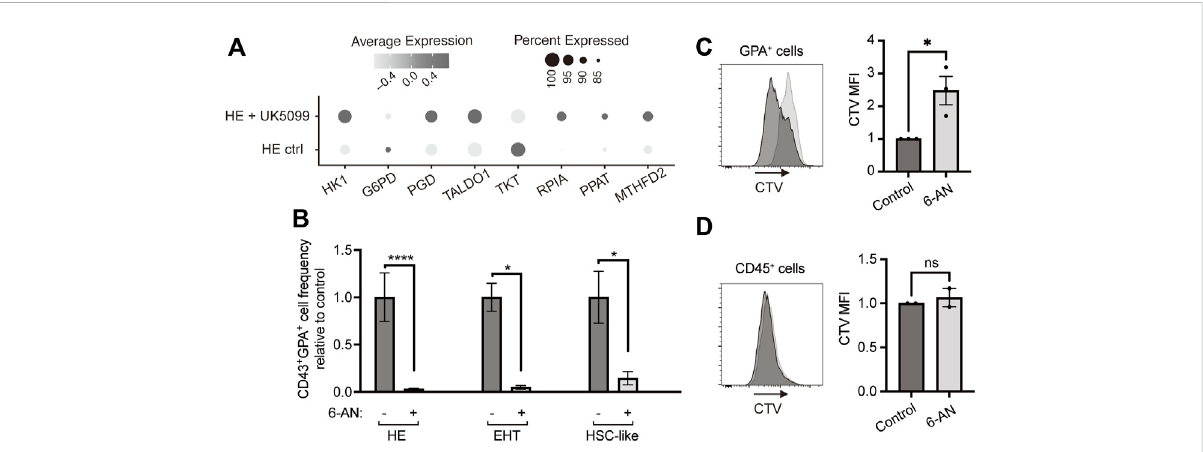
FIGURE 1 BlockingthepentosephosphatepathwayinhibitsHE-derivederythroidcellproliferationandoutput. (A) DotplotsshowexpressionlevelsofPPP enzymes for HE ctrl and HE + UK5099 in hematopoietic clusters from our previously published dataset, as detected by scRNAseq and based on percent expressed (dot size) and average level of expression (color intensity). (B) iPSC-derived HE, EHT and HSC-like cells were subcultured with 25 µM 6-AN and bar graphs show CD43 + GPA + cell frequency ± SEM relative to the untreated control on day 6 ( n = 5 for HE cells and n = 3 for EHT and HSC-like cells, paired t -tests). Culture media was changed every 2 days and inhibitors were added at every media change. (C,D) iPSC- derived GPA + cells (C) or CD45 + cells (D) were sorted on day 13 of hematopoietic differentiation, stained with CellTrace Violet (CTV) dye and treated with 25 µM 6-AN. The CTV dye is diluted with each division and therefore allows to assess proliferation. Mean fl uorescence intensity of CTV was assessed by fl ow cytometry 3 days later. Representative plots and bar graphs ± SEM are shown ( n = 3 for GPA + and n = 2 for CD45 + cells, paired t -tests). ns, not signi fi cant, * p < 0.05, **** p <